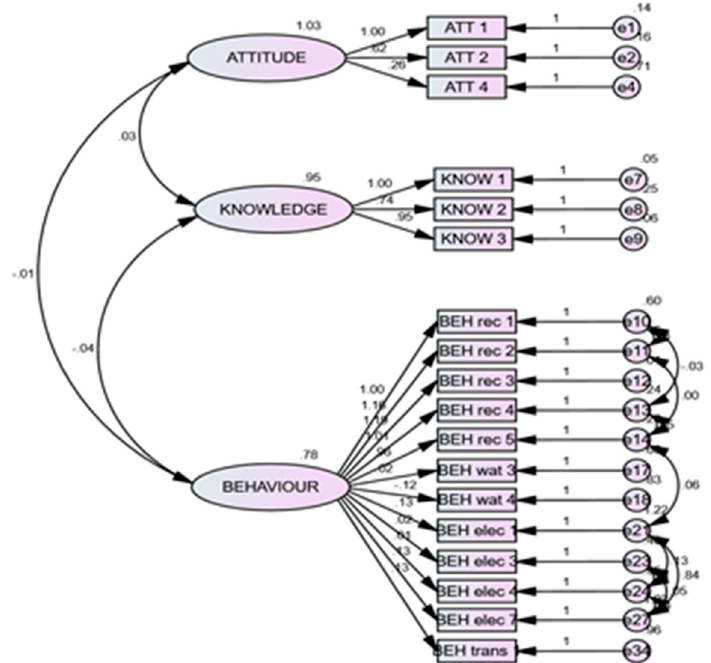
Figure 8. Conceptual measurement model of interrelations among building occupants environmental AKB after Step 2.